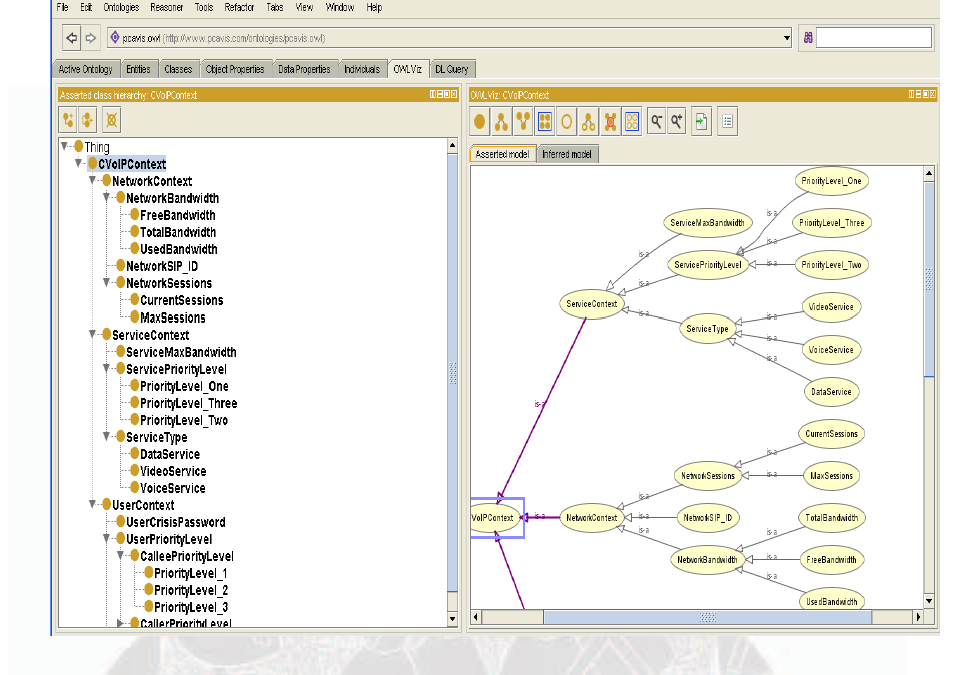
FIGURE 5: VOIP CONGESTION CONTROL SERVICE OWL